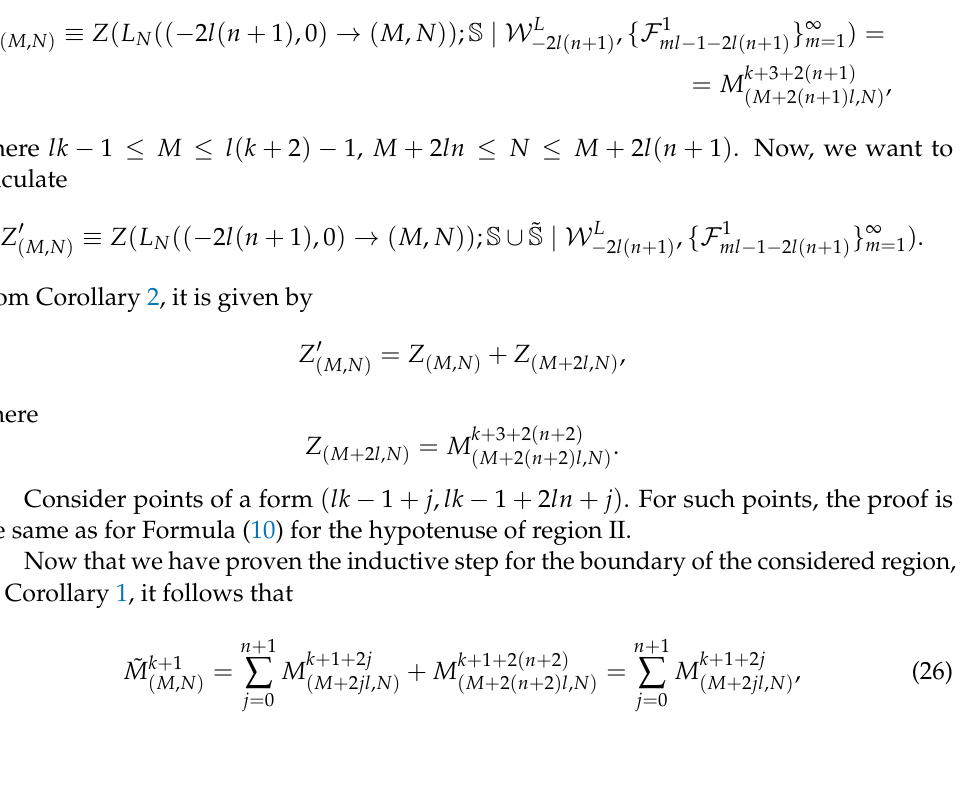
Figure 10. Points M + 2 ln ≤ N ≤ M + 2 l ( n + 1 ) where l ( k + 2 ) − 1 ≤ M ≤ l ( k + 3 ) − 2 are highlighted with blue dashed lines. Union of boundaries for all terms of the considered expression consists of points ( l ( k + 2 ) − 1, N ) for l ( k + 2 ) − 1 + 2 ln ≤ N ≤ l ( k + 2 ) − 1 + 2 l ( n + 2 ) and points ( l ( k + 2 ) − 1 + j , l ( k + 2 ) − 1 + 2 ln + j ) for j = 0, . . . , l − 1. They are highlighted with purple dashed lines. Here, we depict the case where l =